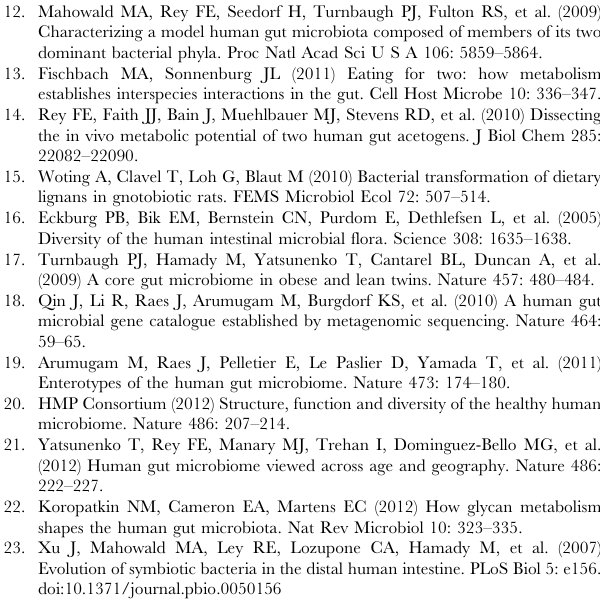
genes), ‘‘Amino acid metabolism’’ ( r = 0.48, 67 genes), and ‘‘Carbohydrate metabolism’’ ( r = 0.69, 110 genes). For both (B) and (C), n = 2 mice per treatment group (4 mice total). Table S1 Sequencing statistics for B. cellulosilyticus WH2. Table S2 B. cellulosilyticus WH2 genome features with relevance to carbohydrate metabolism. Table S3 Composition of the 12-member artificial community inoculated by oral gavage into germ-free animals. Table S4 Bacterial strains included in this study. (XLSB) Table S5 COPRO-Seq quantitation of the relative abundances of artificial community members over time. Table S6 GeneChip measurements of cecal gene ex- pression for the 12 bacterial species comprising the artificial human gut microbial community studied in experiment E 1 . Table S7 List of EC numbers whose representation within the fecal metatranscriptome is significantly impacted by diet. Table S8 Summary of theoretical peptidome statistics.